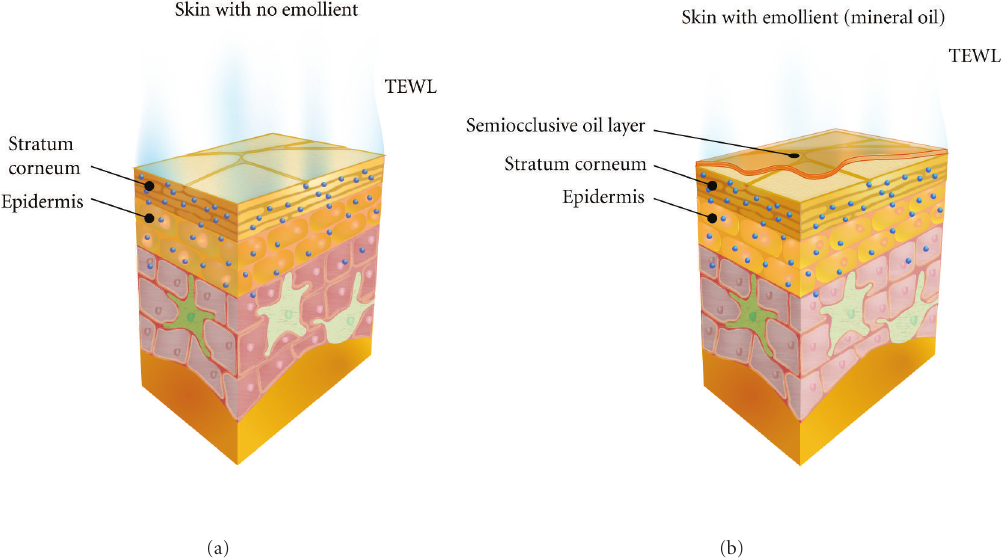
Figure 2: Stratum corneum (SC) moisture retention following application of mineral oil emollient. In (a), transepidermal water loss (TEWL) from the SC is shown under ambient temperature, humidity, and pressure. In (b), TEWL is reduced following emollient application. Oils in the emollient create a semiocclusive layer. The reduction in water evaporation leads to greater water retention in the